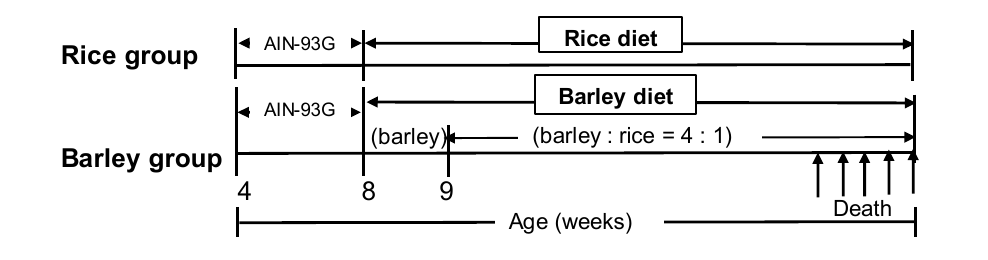
Figure 1. Protocol of feeding.